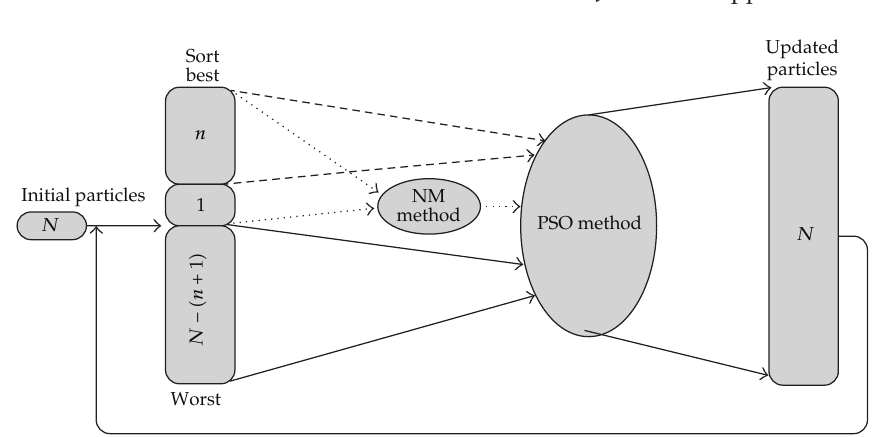
Figure 3: Schematic representation of the proposed M-NM-PSO method.